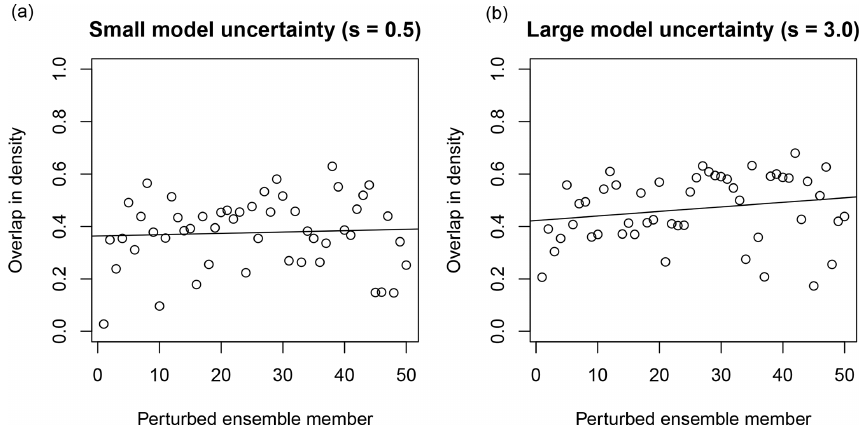
Figure 9. Overlap in source location probability as a proxy for how much new information each ensemble member is adding to the ensemble mean (see text). (a) Results obtained using an uncertainty parameter s = 0 . 5. (b) Results obtained using an uncertainty parameter s = 3 . 0. A linear fit is also plotted (solid black